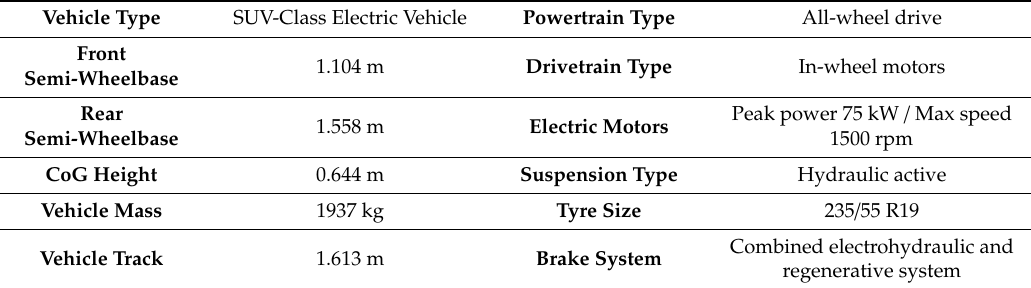
Table 1. Vehicle